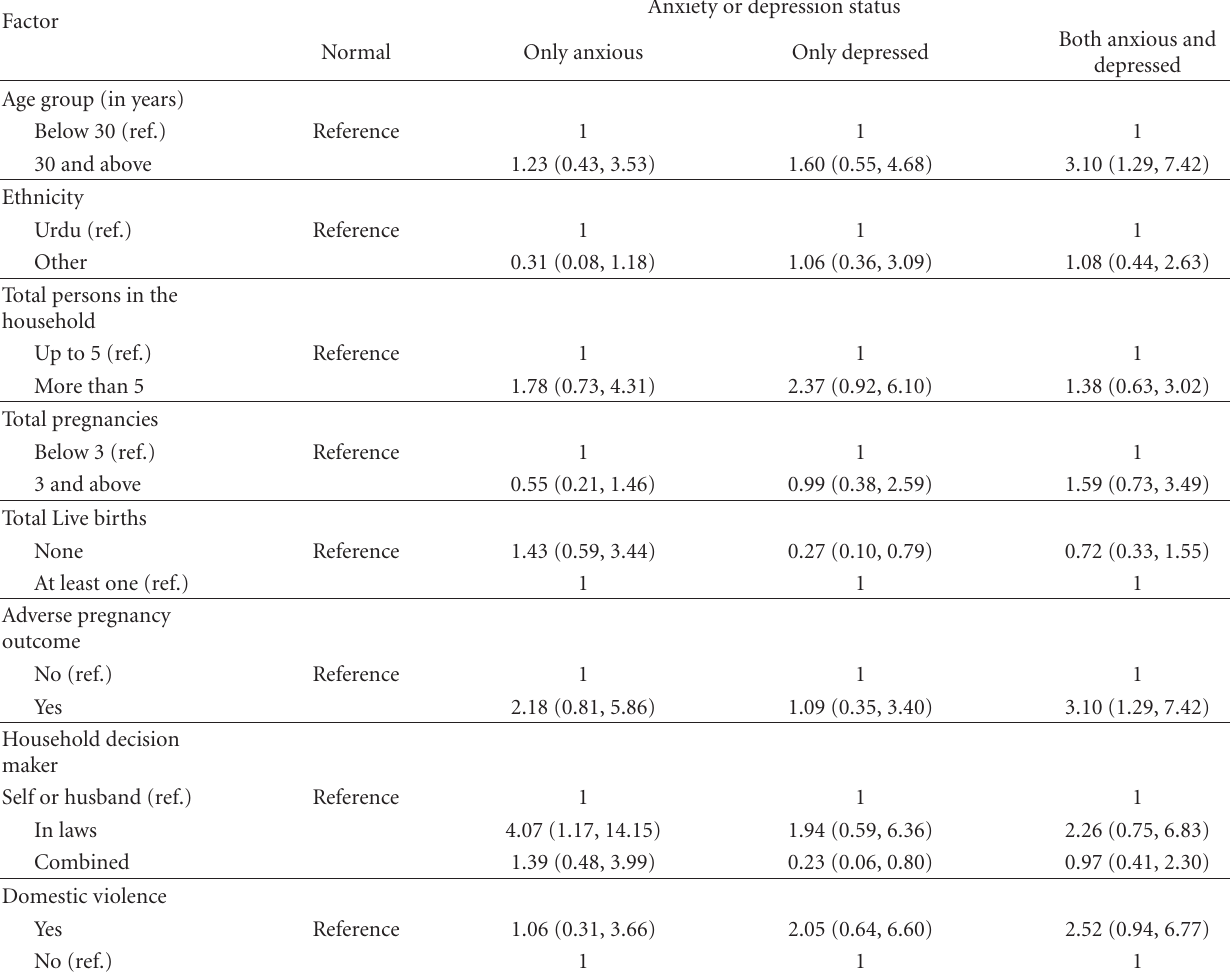
Table 2: Crude odds ratio (95% CI) by sociodemographic, obstetric, family relationships, and home environment characteristics. Anxiety or depression status Factor Both anxious and Normal Only anxious Only depressed